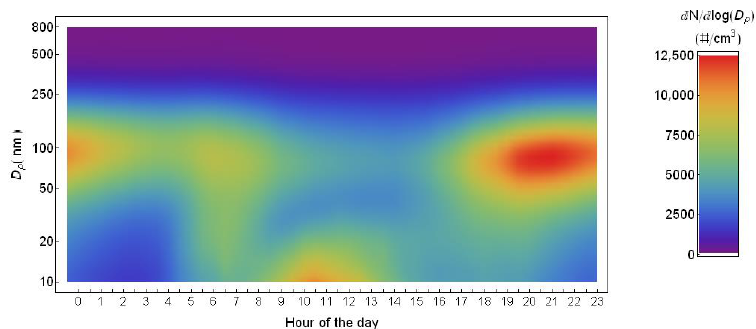
Figure 4. Average daily trend of size distribution.